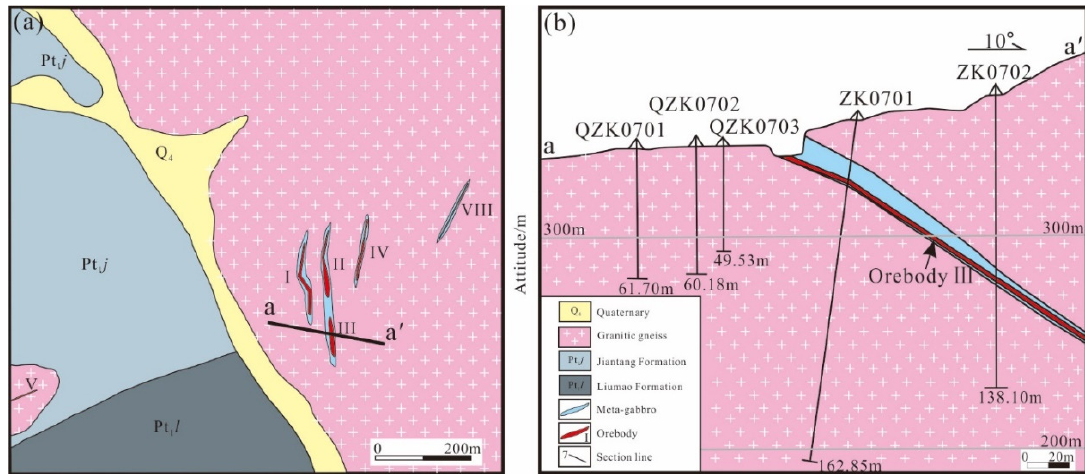
and biotite, with a small amount of sphene (Figure 4f). Associated minerals include fluorite and titanite.